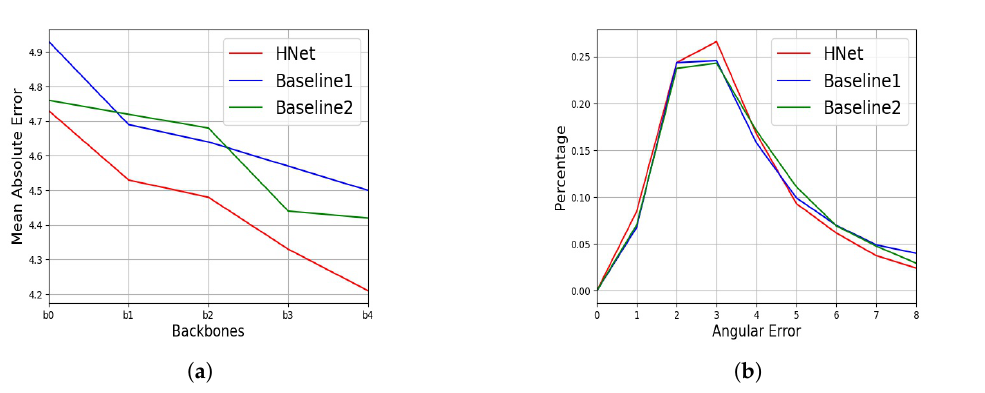
Figure 7. The mean absolute error and percentage of angular errors on the AFLW2000 dataset: ( a ) the mean absolute error when different versions of EfficientNet (b0–b4) were used as the feature extractor; ( b ) the percentage of angular errors using